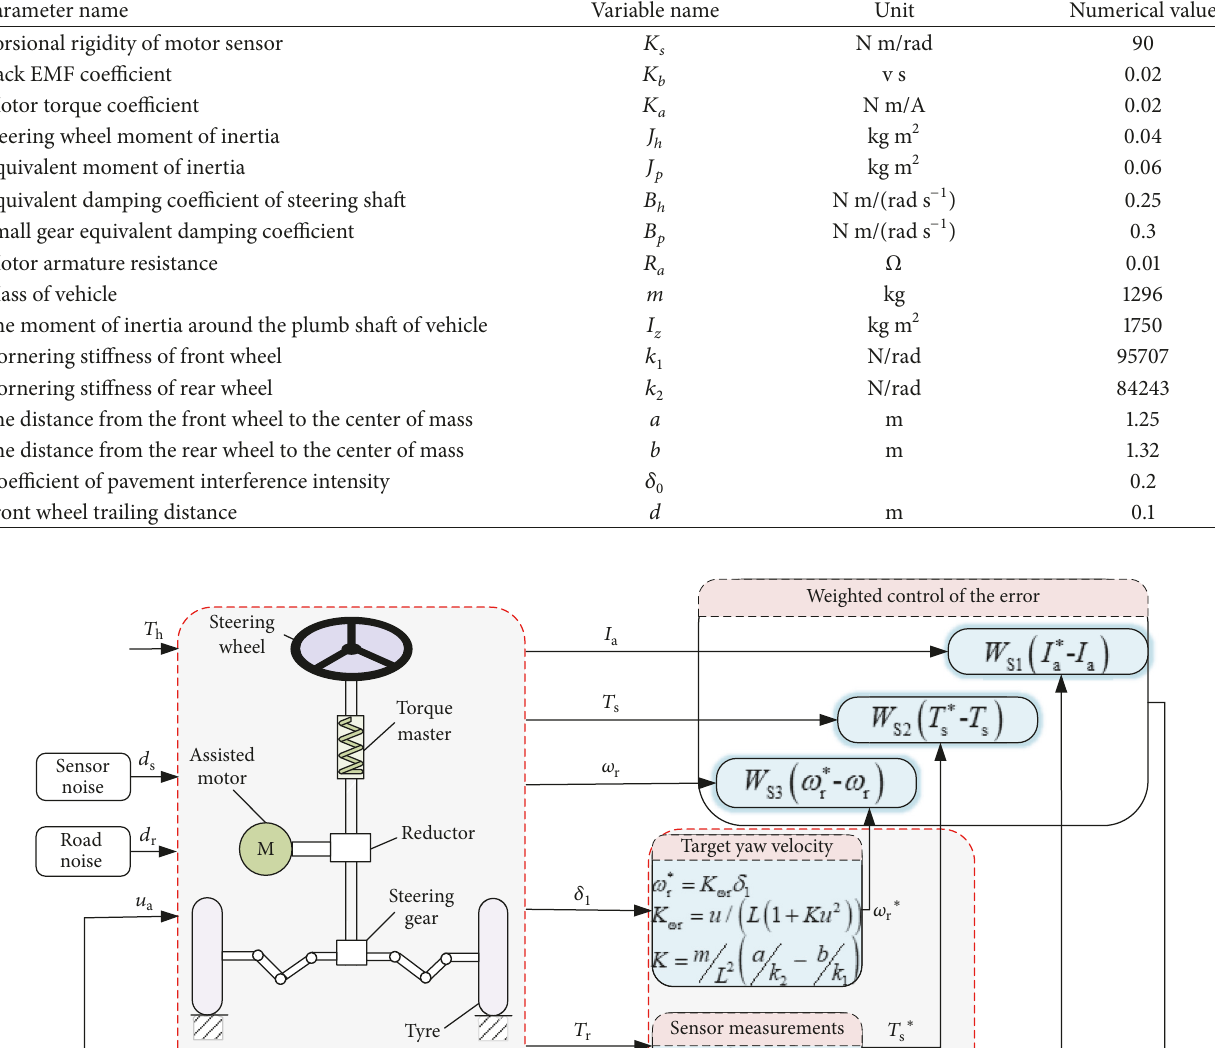
Table 1: Simulation experimental parameters.